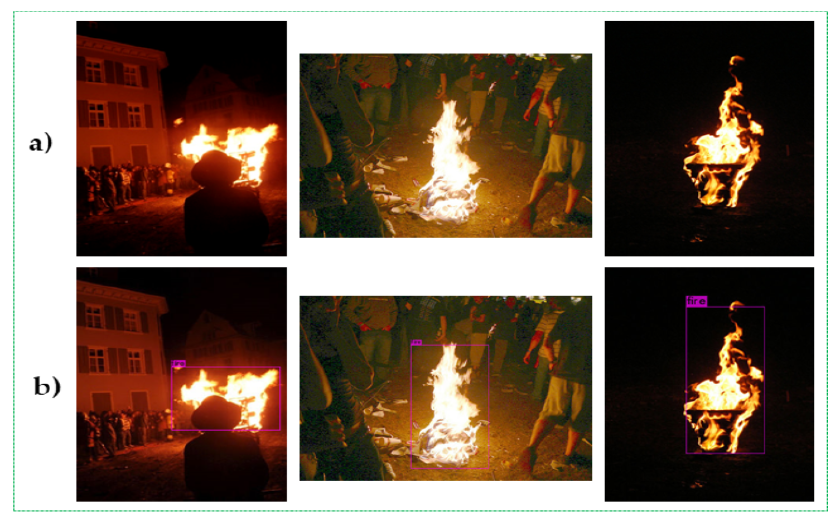
Figure 6. Visible experiment results in daytime fire scenes: ( a ) input image sequences and ( b ) output image sequences with detected fire regions.